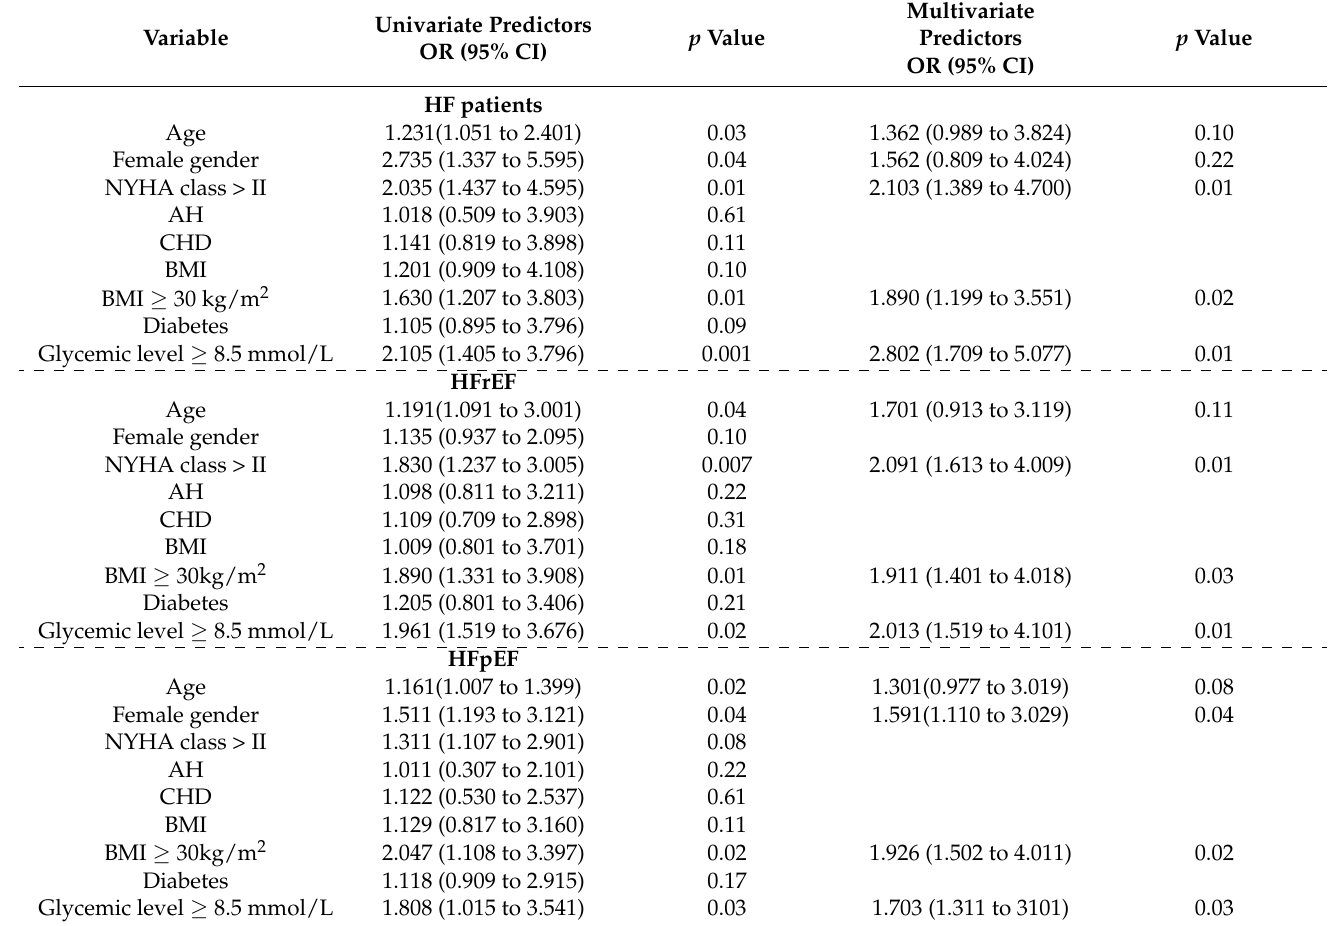
Table 4. Predictors of depression in HF